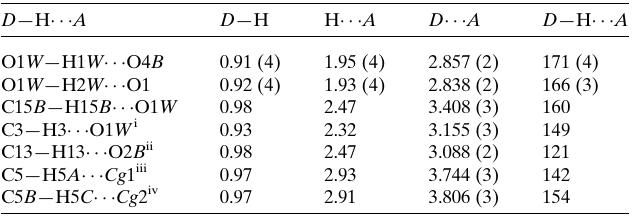
Table 2 Experimental details. Crystal data Chemical